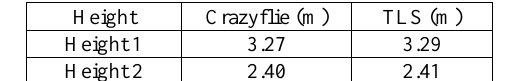
Table 3 . Distances between the floor and the ceiling from the